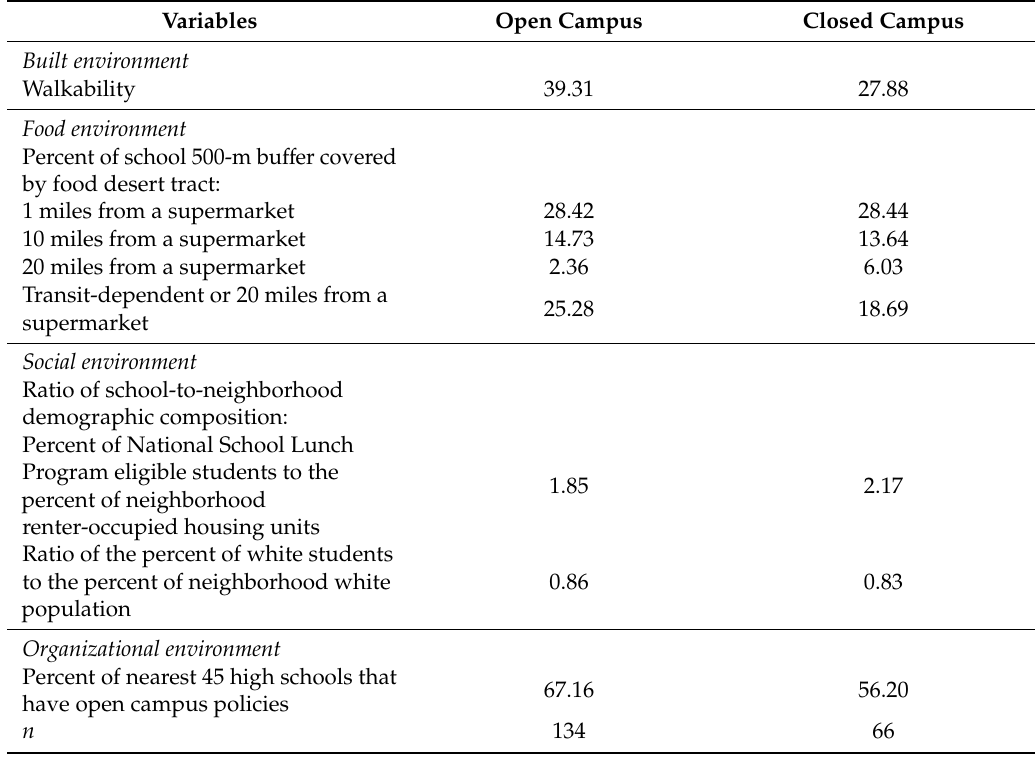
Table 2. Comparison of independent variable means by open campus policy holding ( n = 200 public high